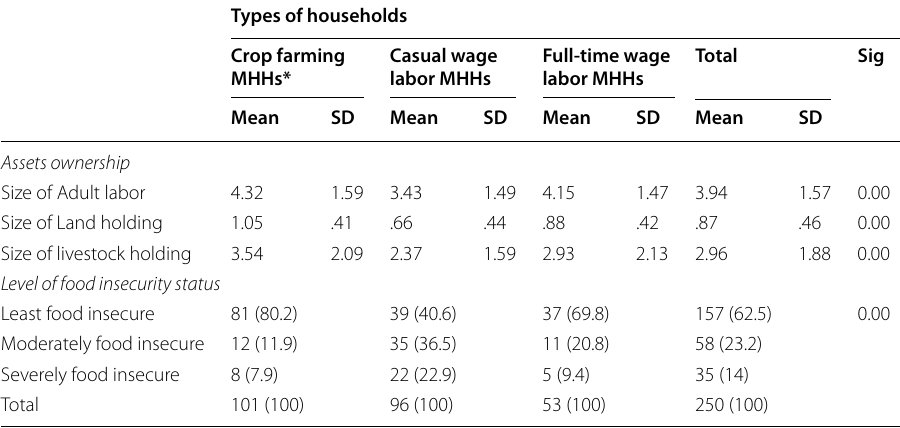
Figures in parenthesis are